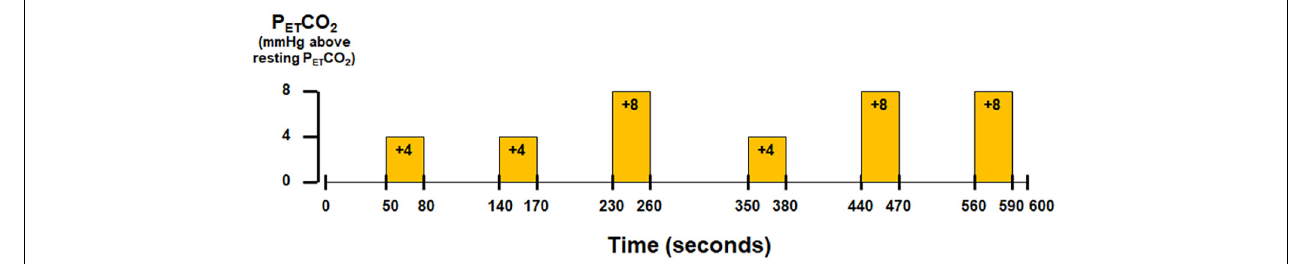
FIGURE 1 | Paradigm of hypercapnic challenge using externally administered CO 2